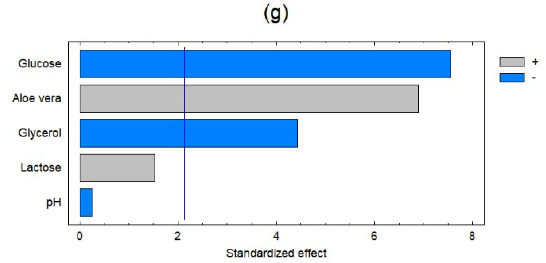
Figure 4. Pareto charts of the standardized effect of different factors on the antifungal capacity of the TEP6 bacteria incorporated into films with 0 days of storage, evaluated on days 1 ( a ), 2 ( b ), 3 ( c ), 4 ( d ), 5 ( e ), 6 ( f ) and 7 ( g ).